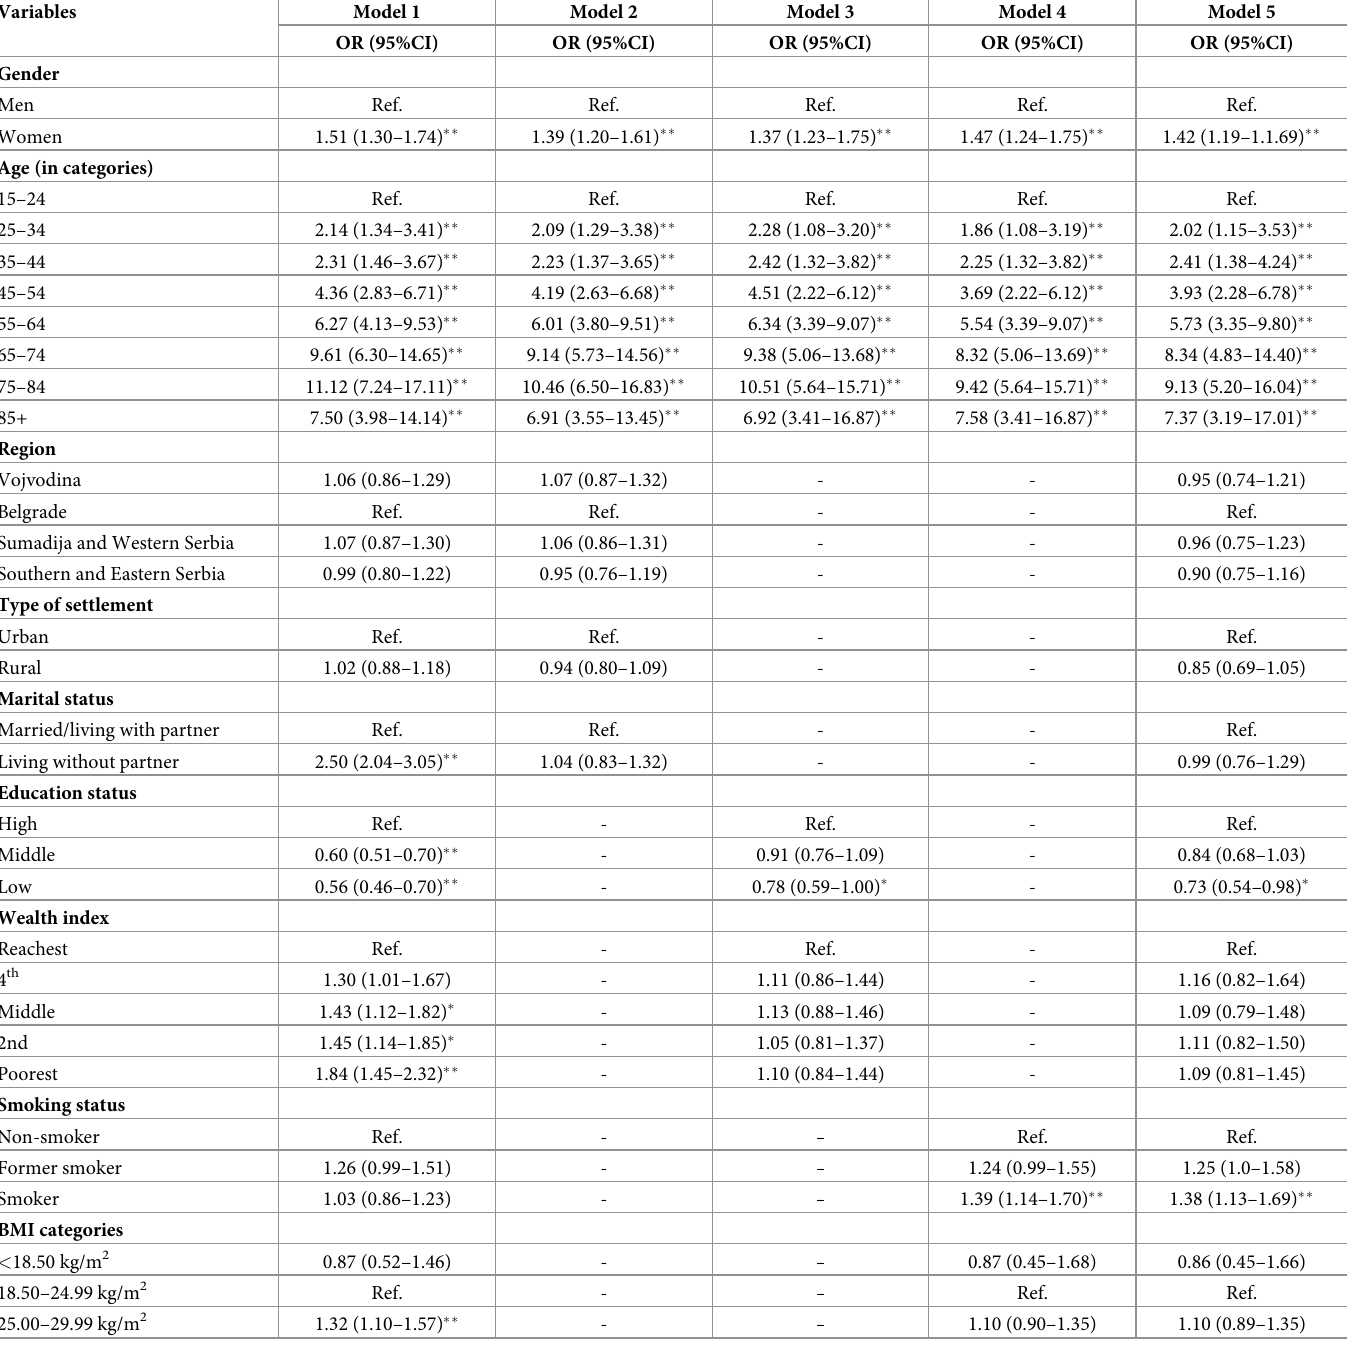
Table 5. Unadjusted and adjusted odds ratios (ORs) for associations between socio-demographic, lifestyle variables and the prevalence of self-reported kidney dis- ease, Republic of Serbia,